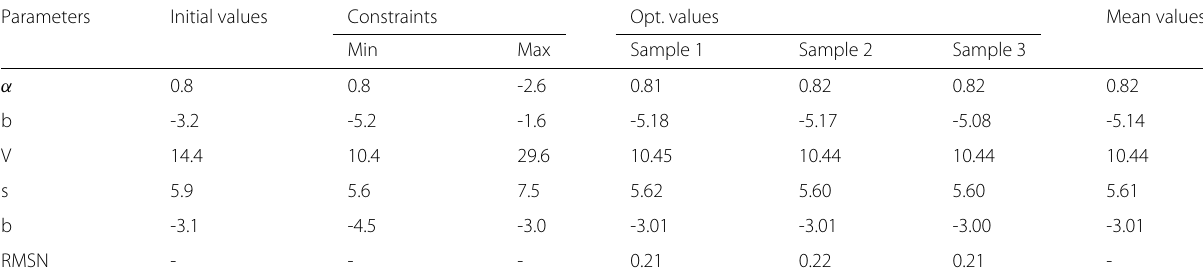
Table 2 Initial values, bounds and optimization results for Gipps’ parameter values Parameters